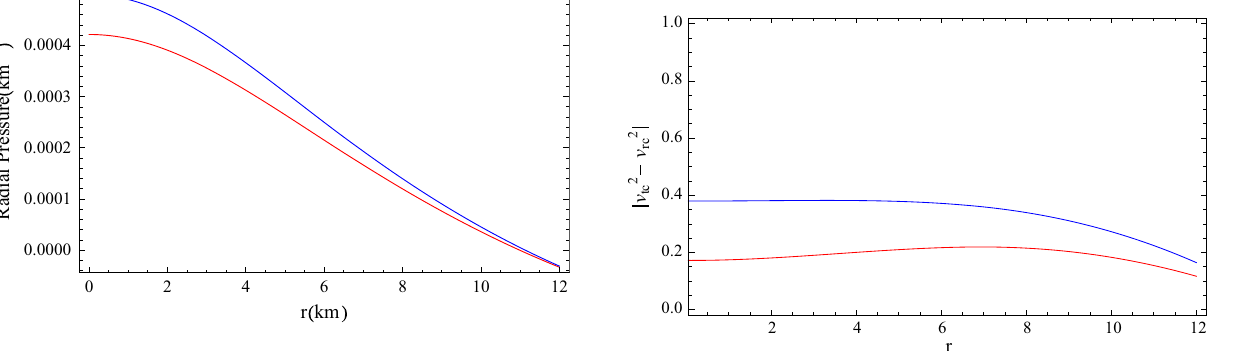
Fig. 15 Variation of radial pressure ( p rc ) with r for PSR J0348+0432 considering β = 1 and matter distribution following Chaplygin EoS [( α = 0 (blue) and α (cid:5)= 0 (red)]